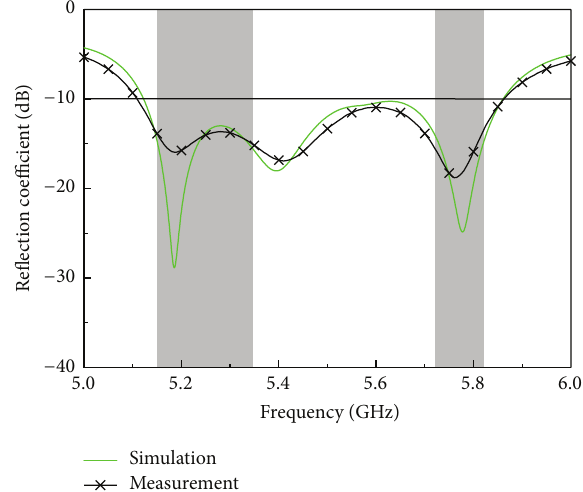
Figure 12: Simulated and measured reflection coefficients of the proposed